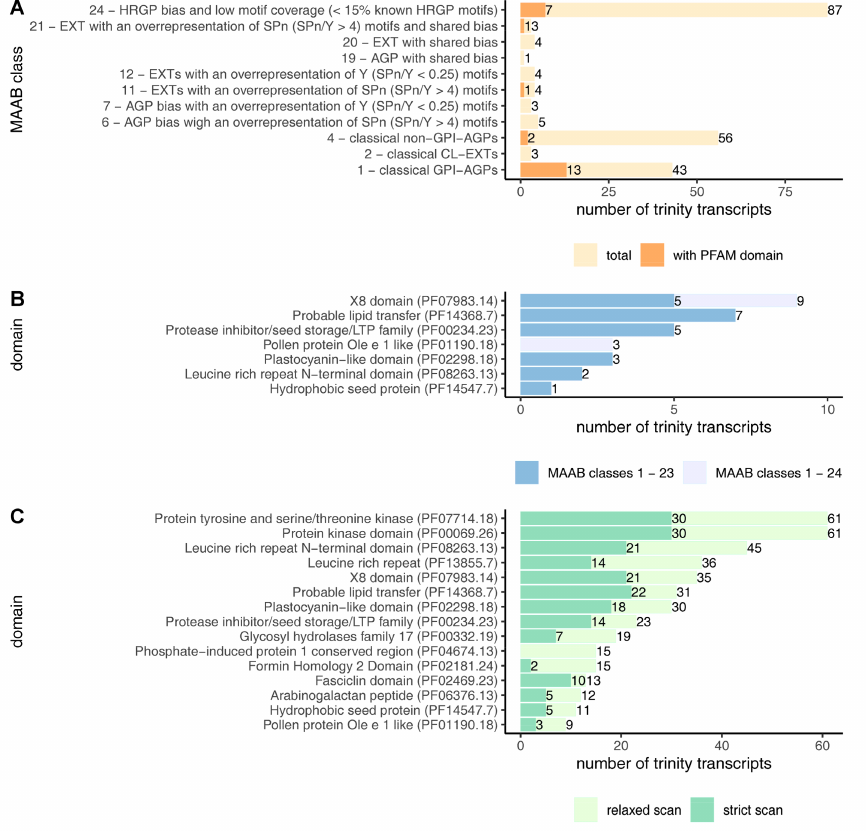
Figure 2. Distribution of identified HRGP sequences in C. erythraea transcriptome. ( A ) Distribution of HRGP MAAB classes. ( B ) Distribution of Pfam domains in sequences identified as one of the MAAB classes. ( C ) Distribution of Pfam domains (top 15 by frequency) in sequences containing clusters of AG motifs, using a relaxed scan (three AG motifs no more than 10 amino acids apart) and a strict scan (four AG motifs no more than four amino acids apart). Unique domains per sequence were counted. Only AG motifs with prolines likely to be hydroxylated were considered. AG motifs linked to three or more continuous prolines/hydroxyprolines were omitted from the scan (example AOOO). Domains were predicted with hmmscan 3.3.2 and using Pfam-A33 database using a cutoff of 0.01 for independent